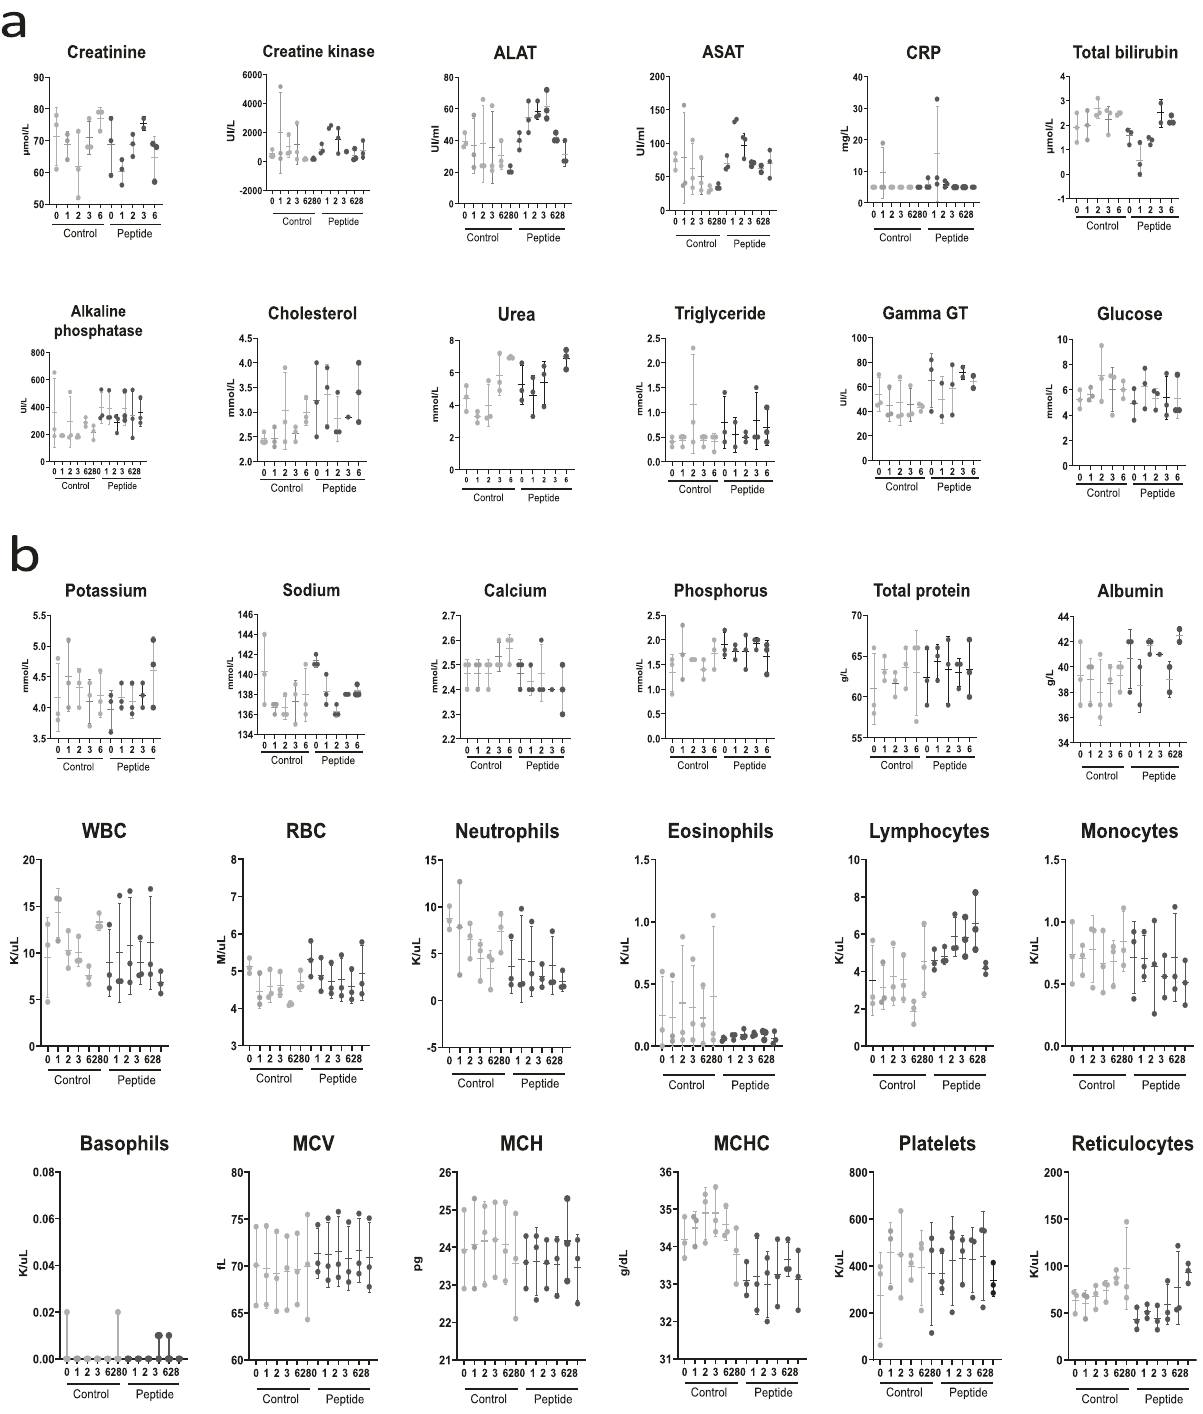
solution (0.9%NaCl, n =3) or HRC4 peptide (4mg/kg, n=5). ALAT Alanine amino- transferase, ASAT Aspartate aminotransferase, CRP C-reactive protein, MCV Mean corpuscular volume, WBC white blood cells, RBC red blood cells, MCH Mean cor- puscular, MCHC Mean corpuscular haemoglobin concentration. Data are